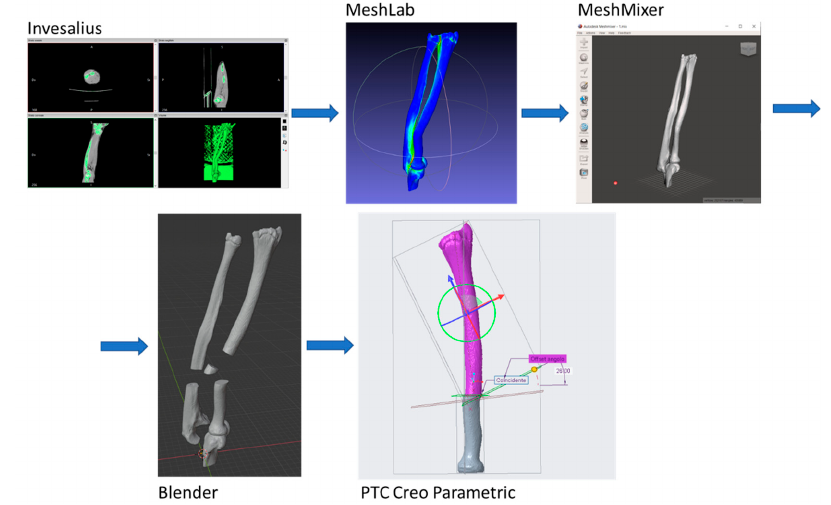
Figure 1. Steps to convert a 2D Computed Tomography (CT) scan to the final 3D simulation.